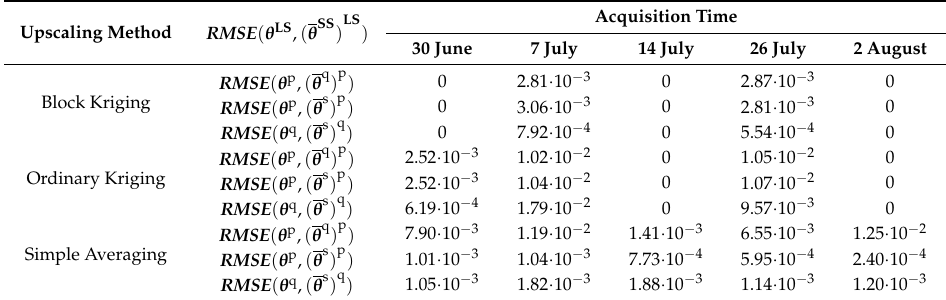
Table 4. Comparison of the upscaled soil moisture estimations of the larger scale (LS) pixels and the averaged value of the smaller scale (SS) pixel estimations within each LS pixel based on block kriging, ordinary kriging, and simple averaging and using root mean squared error (RMSE): RMSE ( θ LS , ( θ SS ) (m 3 · m − 3 ).